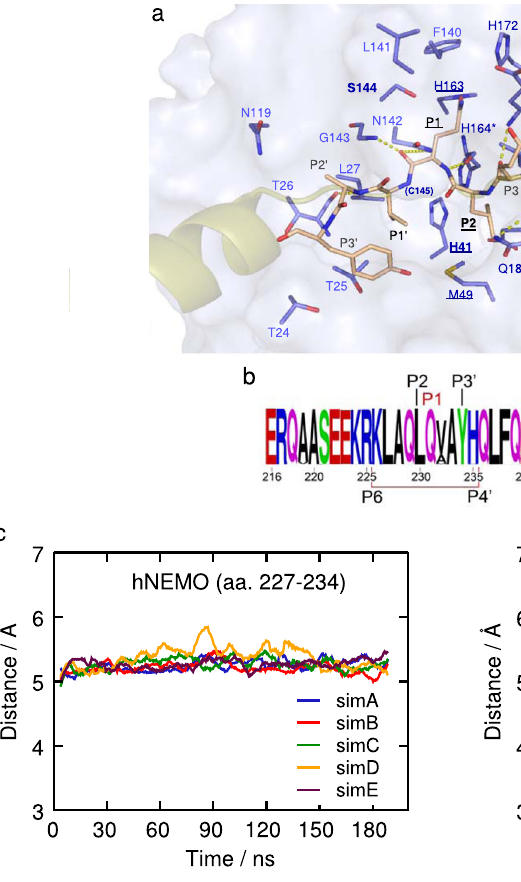
Fig. 3 | Molecular dynamics simulations of SARS-CoV-2 3CLpro bound to human ormouse NEMO. a Main contacts from MD simulations and predicted hot spots in WT 3CLpro bound to human NEMO 227 – 234 . Contacts that persist for more than70%ofthesimulationtimearedepicted.HotspotspredictedwitheitherKFCa orKFCbarelabeledinboldandthosepredictedwithbothmethodsareunderlined. Persistent H-bonds are shown as dashed lines (Supplementary Table 2). A repre- sentative conformation of the short (aa. 227-234) and long constructs of NEMO in